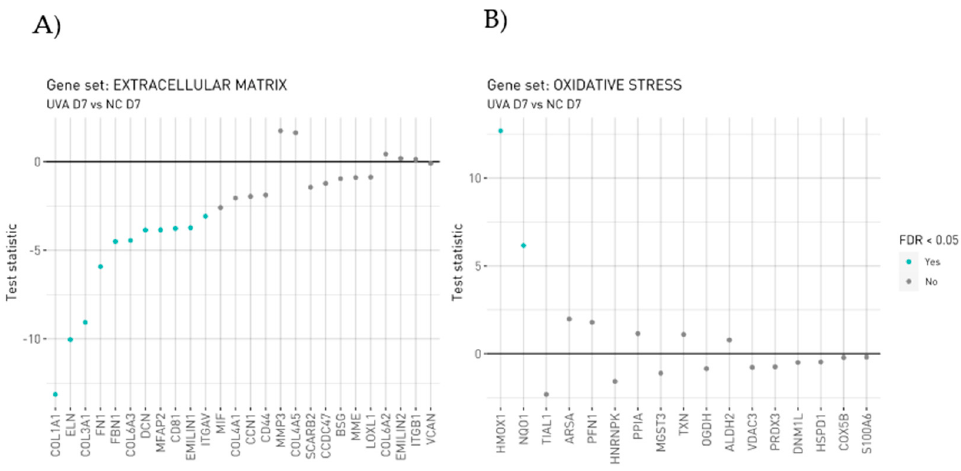
Figure 4. Gene level statistics for genes within the manually curated gene sets. ( A ) ECM genes altered by UVA_D7 vs. NC_D7. ( B ) Oxidative Stress genes altered by UVA_D7 vs. NC_D7. Statistics correspond to those from the differential expression analysis comparing UVA_D7 vs. NC_D7. Analysis was performed in triplicate; each replicate is a pool of 20 spheroids on 150 – 200 µm in size diameter. Table 3. Proteins involved in the Wound Healing Signaling